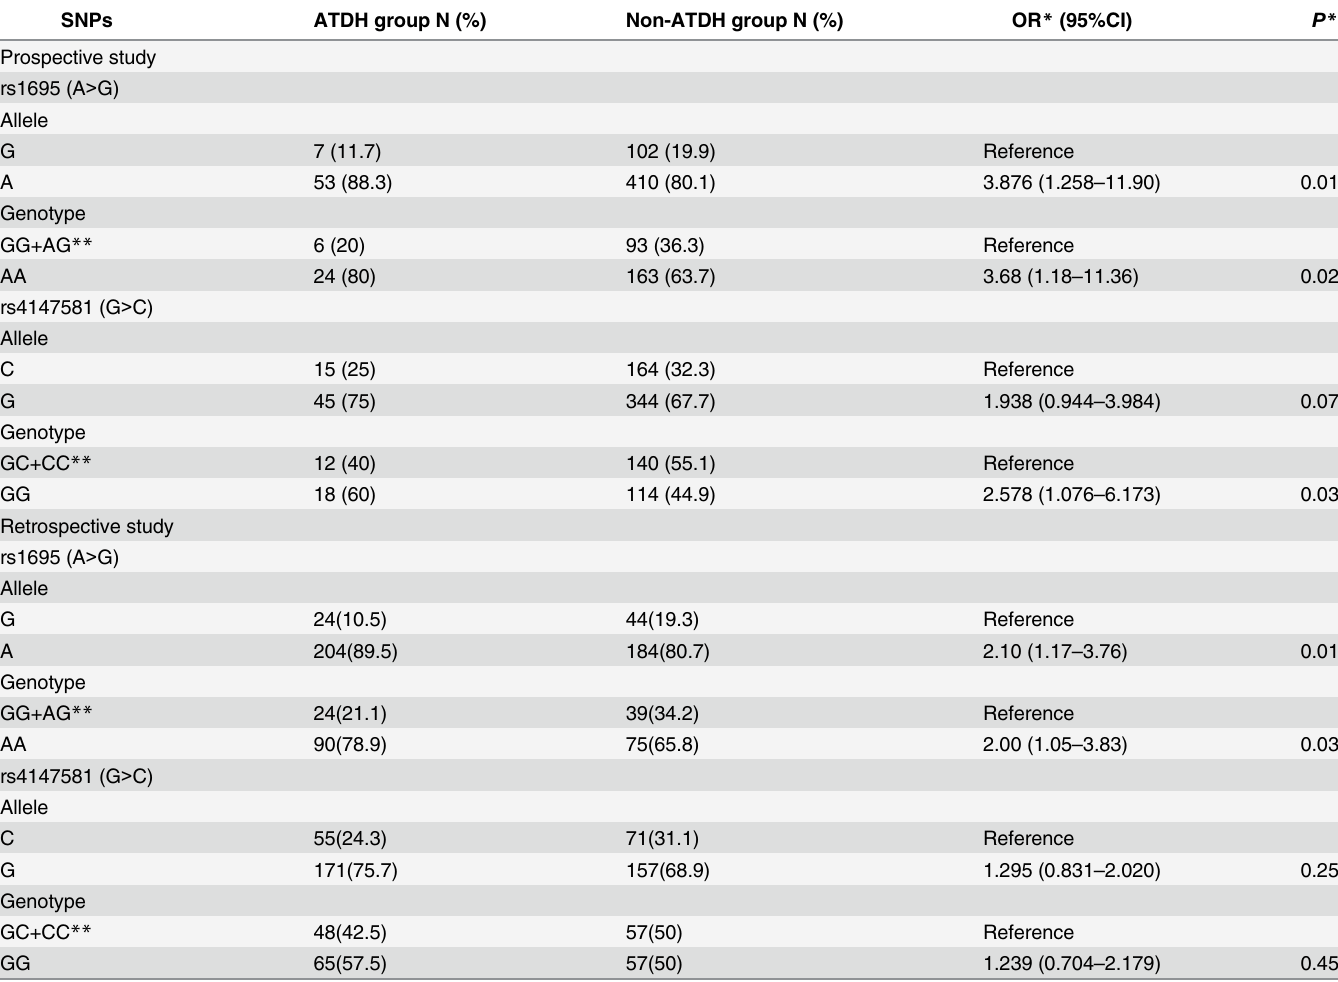
Table 2. GSTP1 polymorphisms in patients with and without